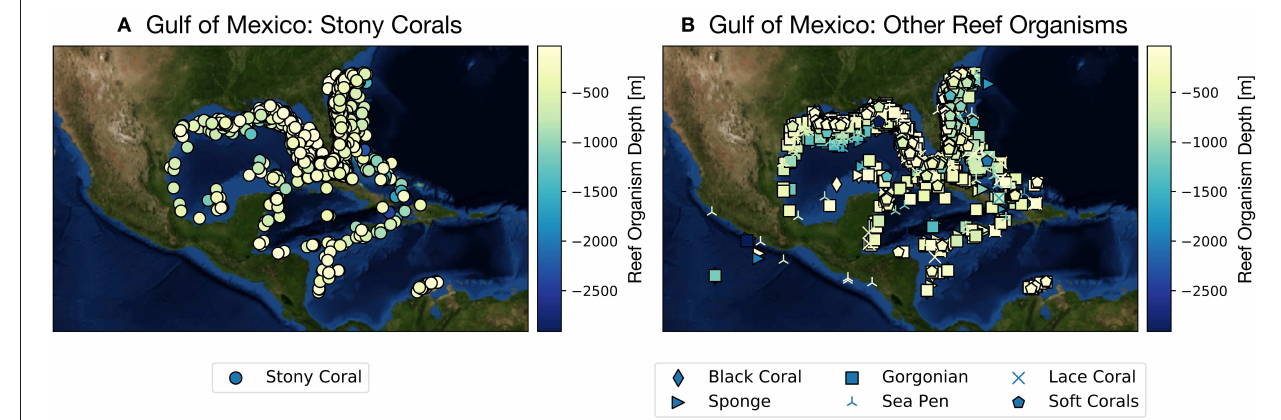
FIGURE 1 | Gulf of Mexico shallow and deep sea coral and sponge sites as reported in the deep sea coral database (NOAA, Figures S1, S2 ). Color scale along y-axis indicates depth of reef organism and symbols denote organism type (e.g., scleractinian coral vs. sponge). (A) Scleractinian corals (stony corals), (B) all other species reef locations. See also Figures S1, S2 . From